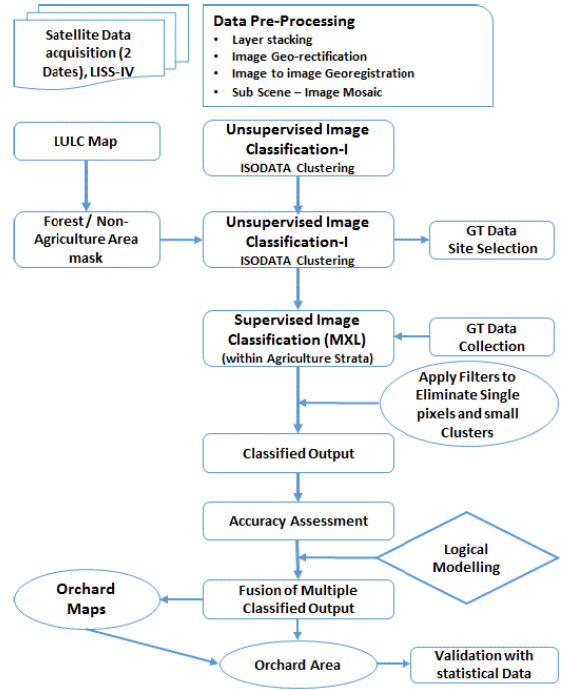
Figure 2. Step-wise algorithm for orchard mapping